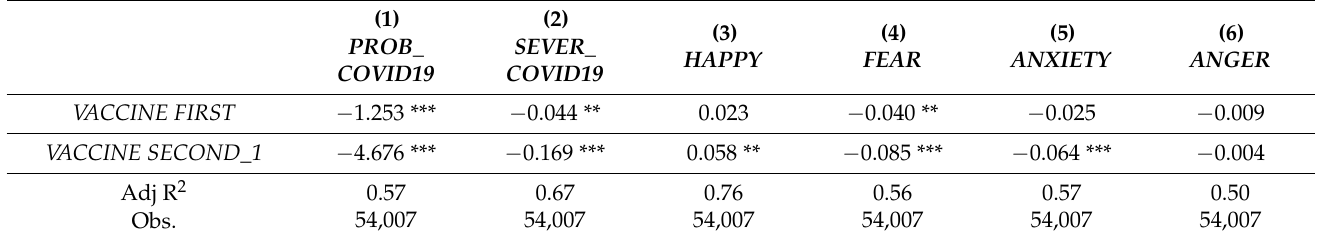
Table 4. FE model. Dependent variables are perceptions of COVID-19 and mental health. Sample including males and females. (Alternative